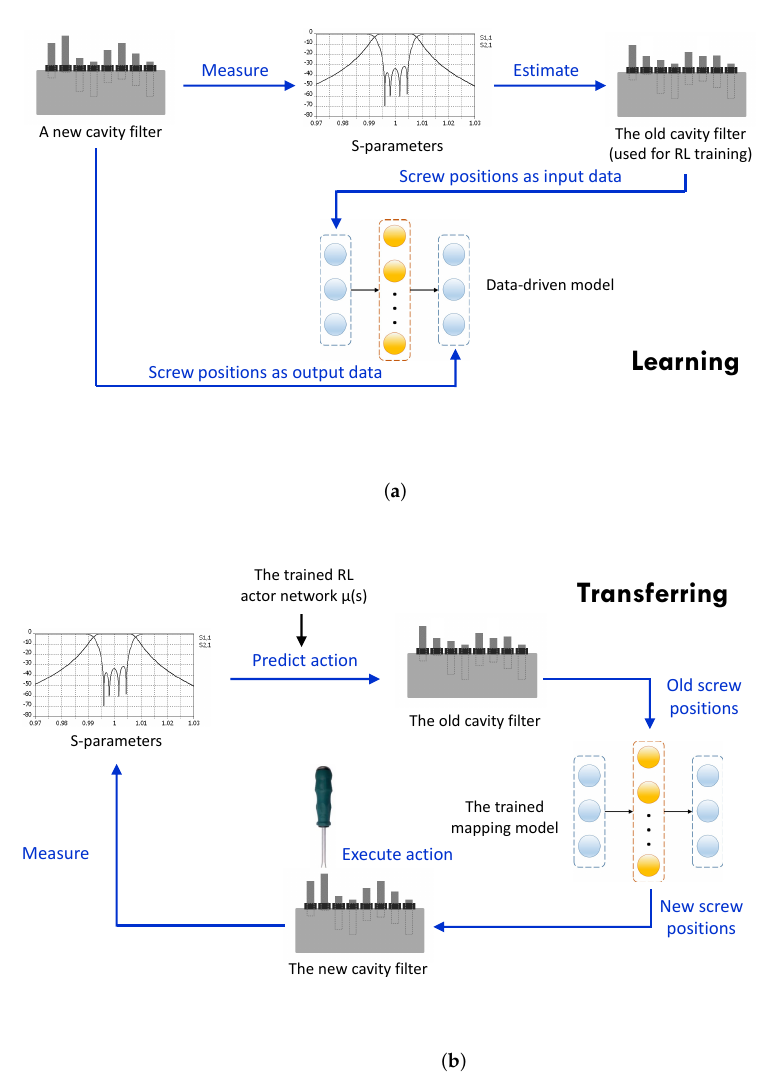
Figure 5. The policy generalization framework: ( a ) The learning phase: learning the filter mapping model. ( b ) The transferring phase: transferring the learned RL policy to a new individual with the mapping